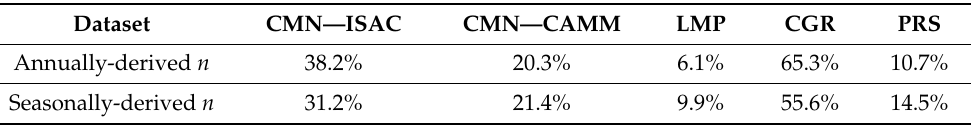
Table 4. For each analyzed dataset, percentage of data discarded by adopting in BaDS the annually- derived or the seasonally-derived n